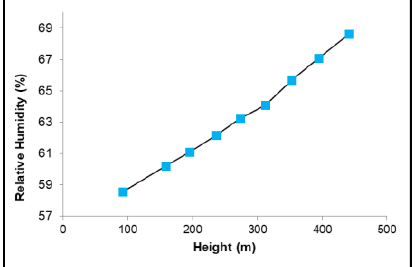
Figure 20. Vertical profile of relative humidity during the flight